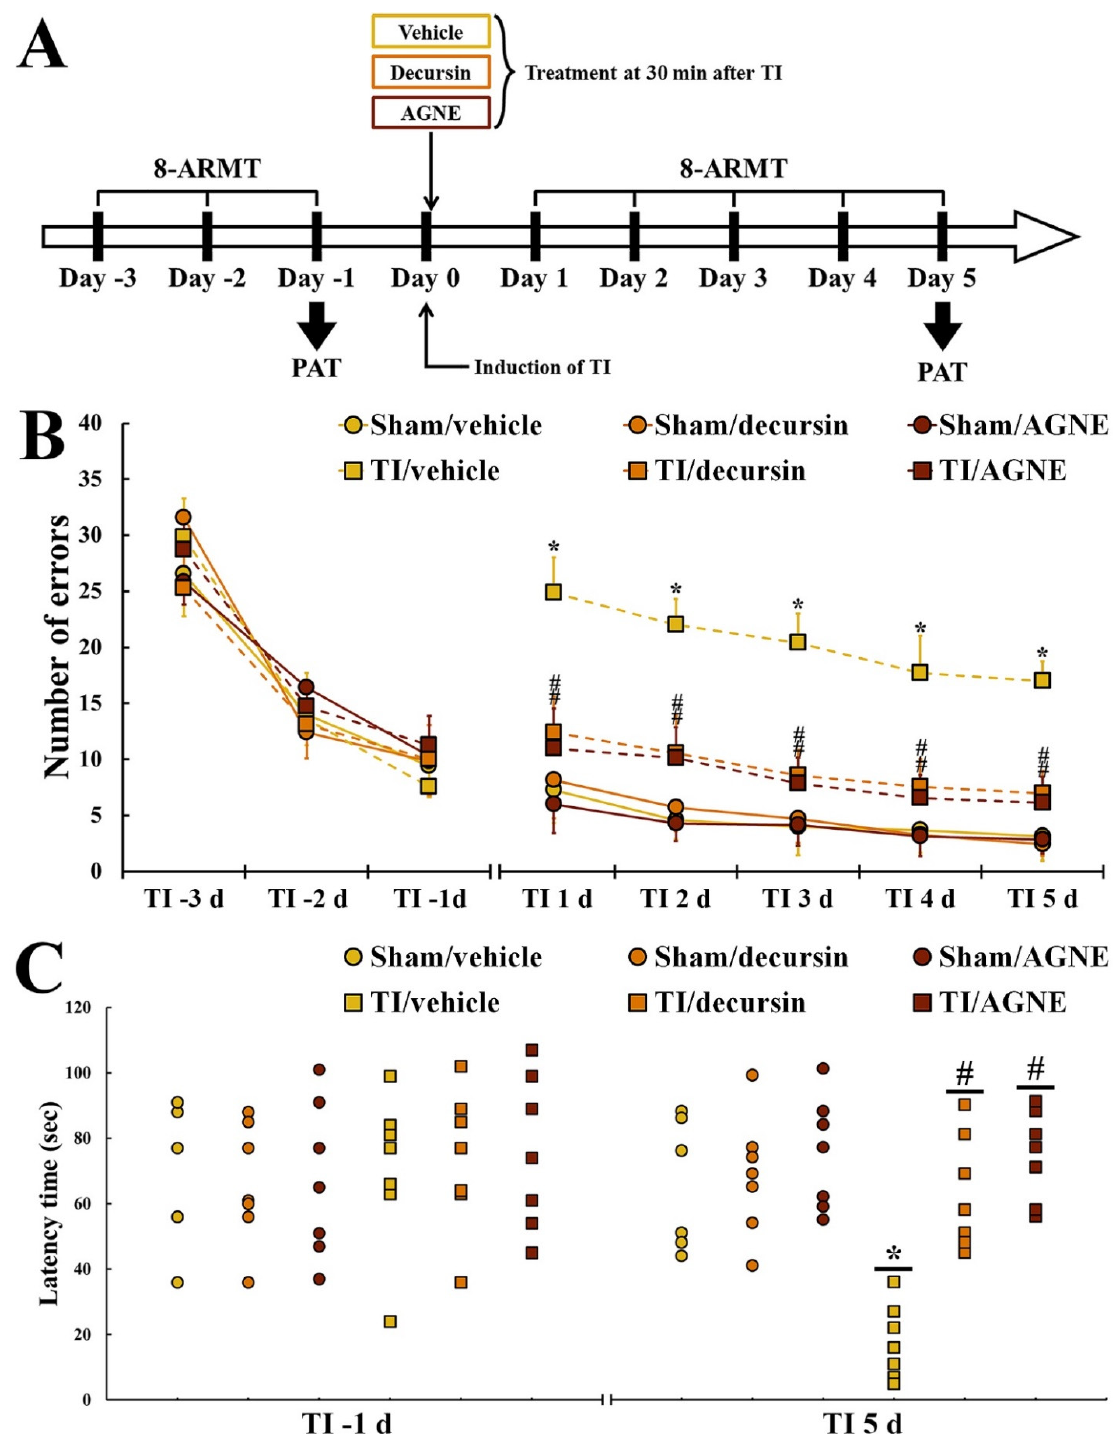
Figure 4. Experimental timeline ( A ), the mean number of errors in an 8-arm radial maze test (8-ARMT) ( B ) and latency time in a passive avoidance test (PAT) ( C ) in the sham/vehicle, sham/decursin, sham/AGNE, TI/vehicle, TI/decursin, and TI/AGEN groups at 3 days, 2 days, and 1 day before TI, and 1 day, 2 days, 3 days, 4 days, and 5 days after TI. The number of the errors in both TI/decursin and TI/AGNE groups are significantly reduced after TI compared with the TI/vehicle group. In addition, the latency time in the TI/decursin and TI/AGNE groups is significantly longer than that in the TI/vehicle group at 5 days after TI. The bars indicate the means ± standard error of mean (SEM) ( n = 7 per group, * p < 0.05 versus sham/vehicle group, # p < 0.05 versus TI/vehicle group).